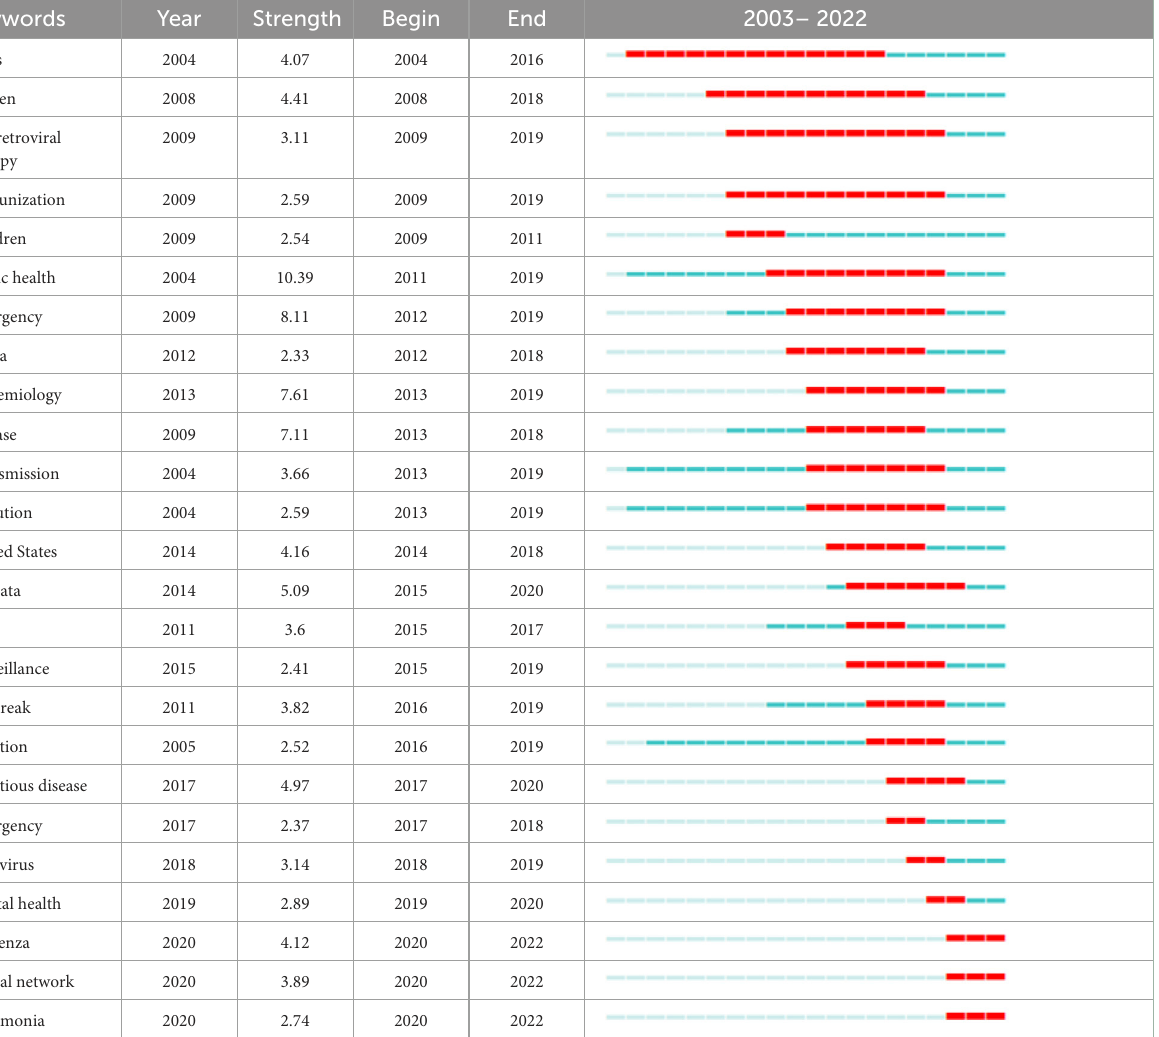
TABLE 3 Top 25 keywords with the strongest citation